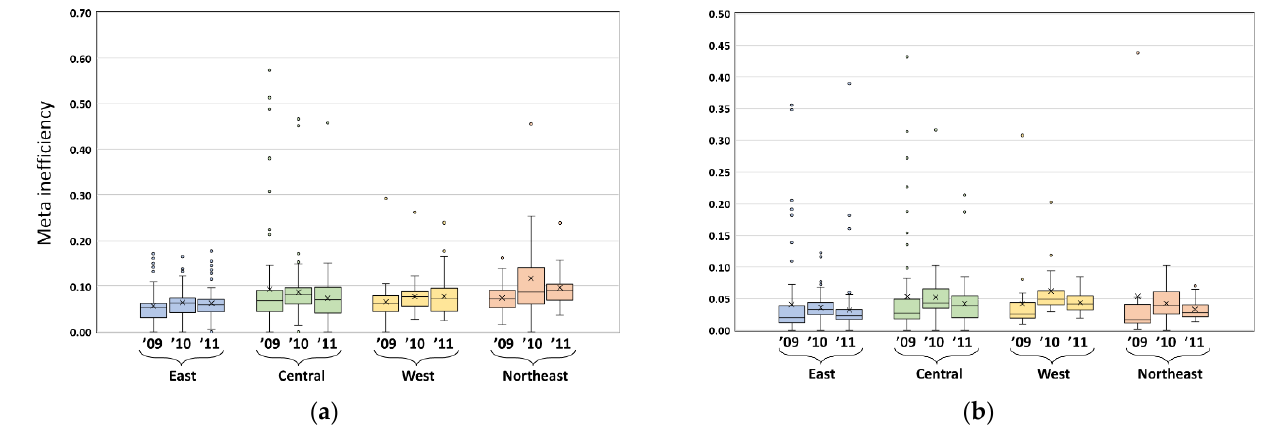
Figure 2. Boxplots of meta inefficiency in ( a ) the small – medium (SM) group and ( b ) the LARGE group by year and region. ’09, ’10, and ’11 refer to the years 2009, 2010, and 2011, respectively. “ × ” and “°” stand for the average value and outliers, respectively.